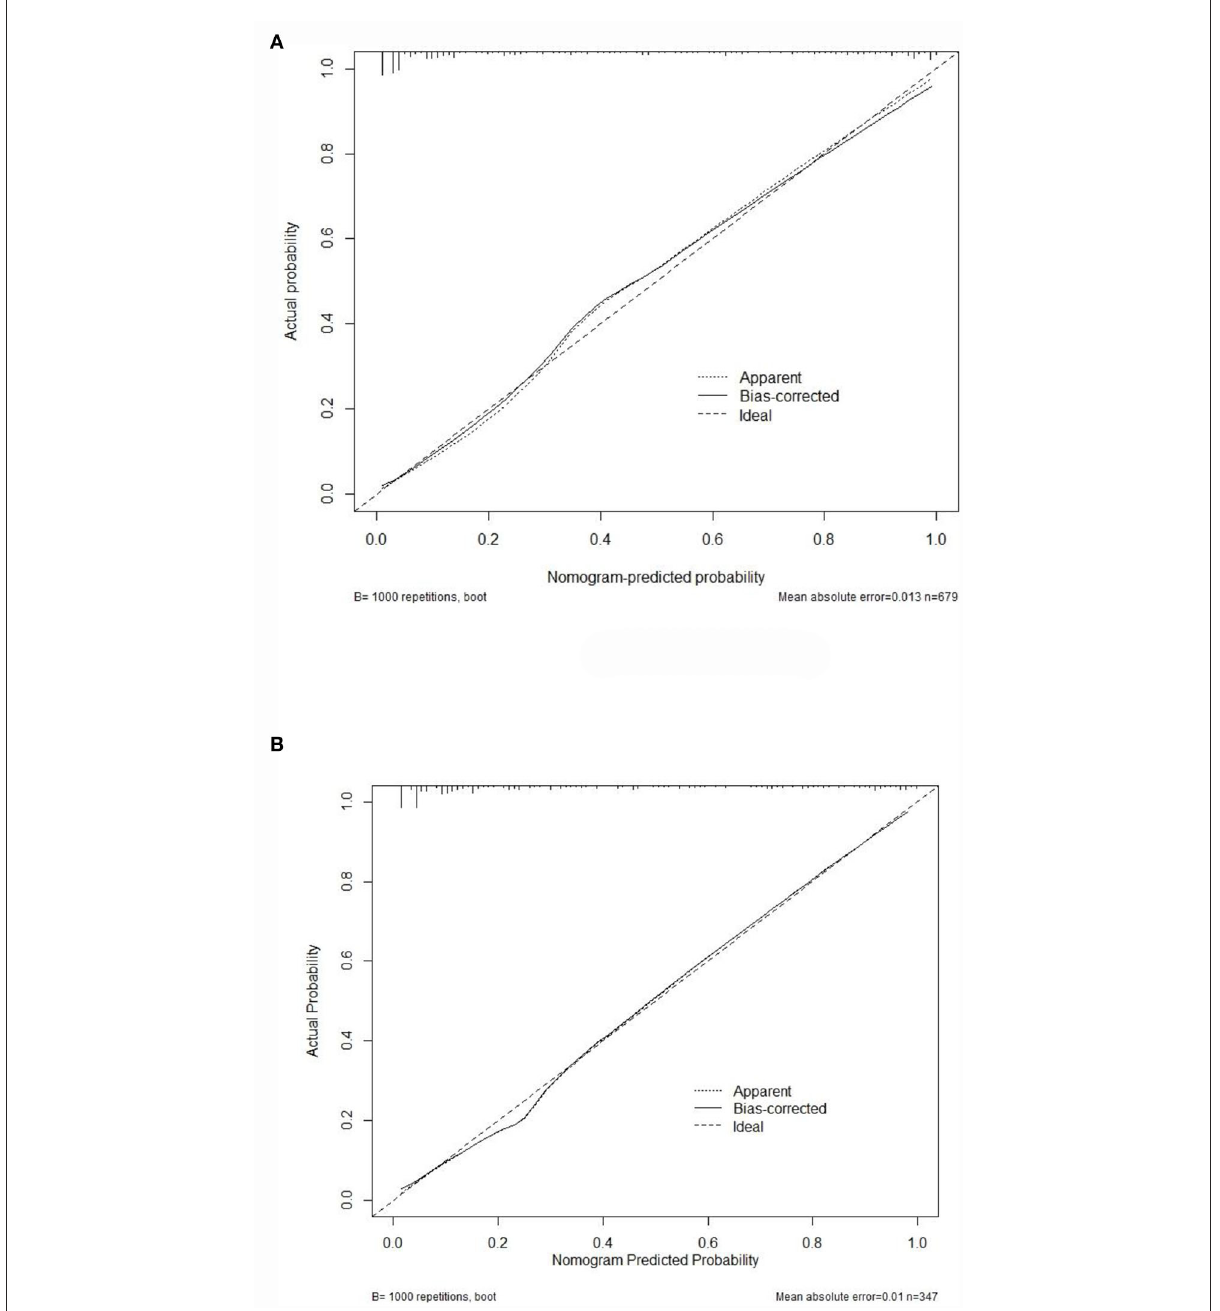
FIGURE5 The calibration curves for the nomogram. Calibration plots of predictive DRE risk in the training set (A) as well as the external validation set (B) . The x-axis showed the nomogram-predicted probability, while the y-axis showed the actual probability of DRE. Perfect prediction would correspond to the 45 ◦ dashed